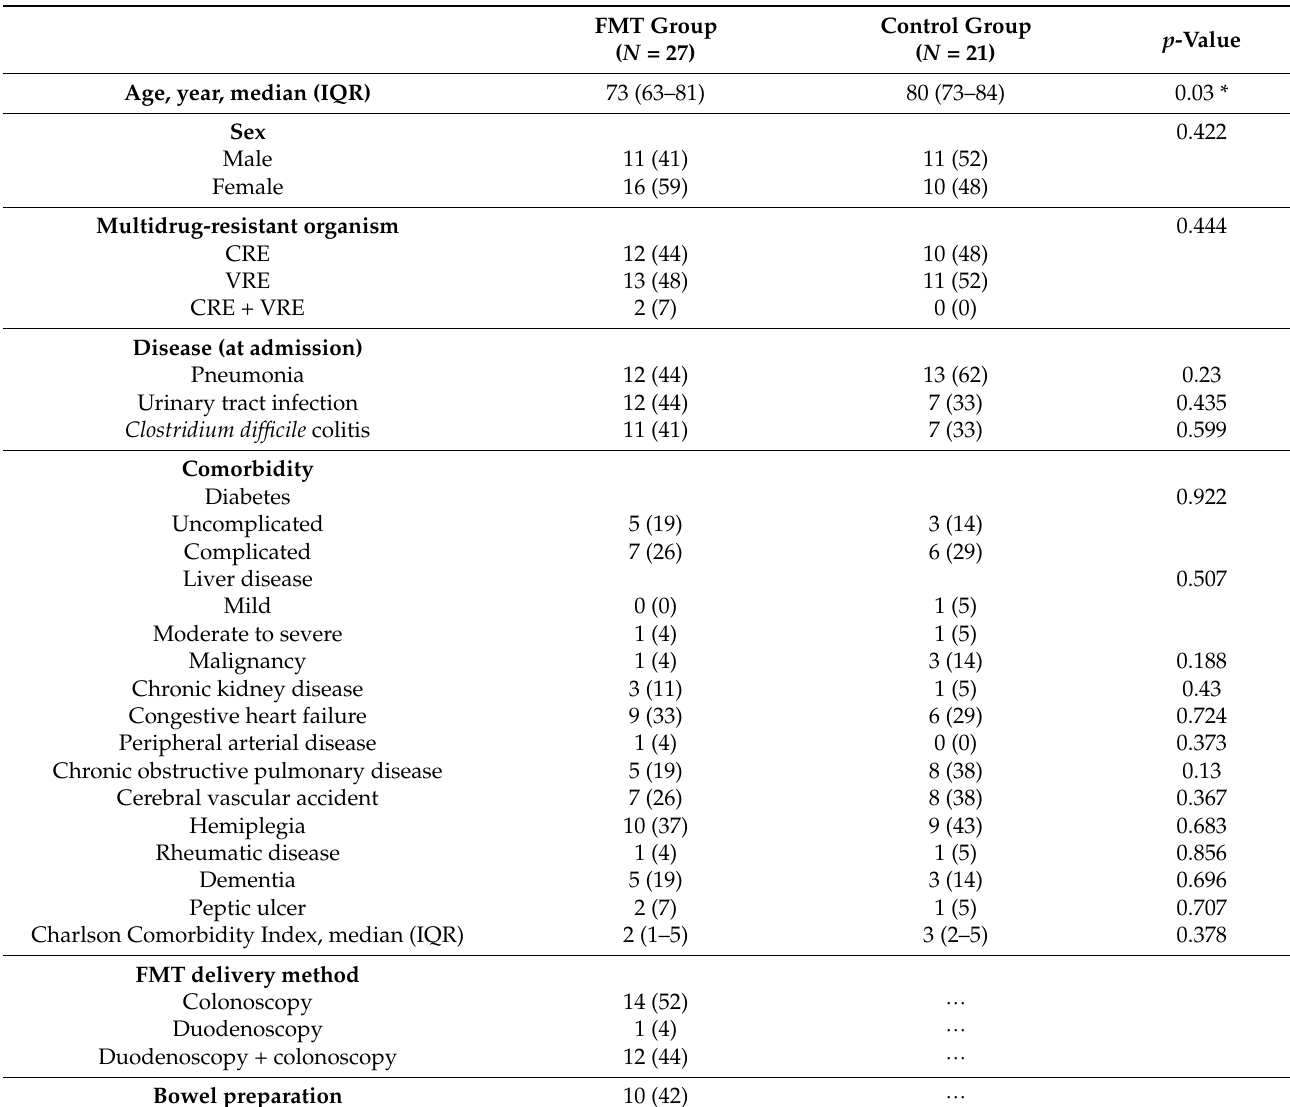
Table 1. Comparison of the baseline clinical characteristics of the enrolled patients between the FMT and control